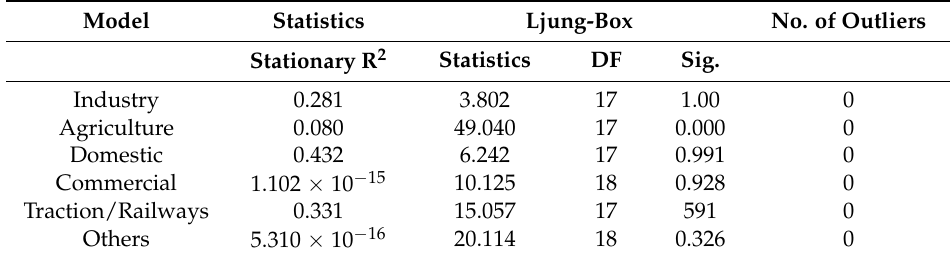
Table 7. Summary of the model.